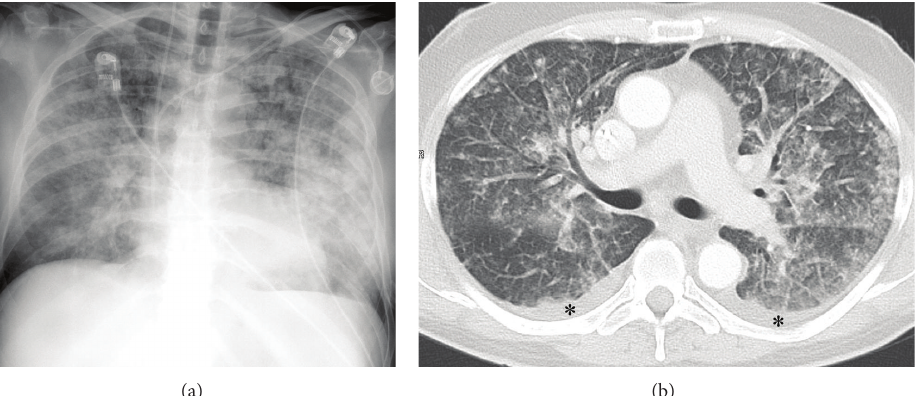
Figure 2: X-ray (seven days after inpatient admittance) and CT scan of the chest (five days after initiation of chemotherapeutic treatment). Patchy airspace consolidation with peribronchial and peripheral distribution. Small pleural effusion bilaterally (black asterisk).